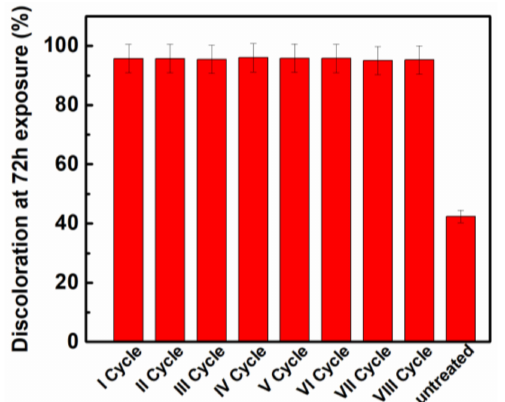
Figure 11. The repeated experiments performed for the sample PL-D under the solar light simulator. The recycling performance was investigated in forty-eight consecutive photocatalytic experiments. For each cycle, the same stone was stained with MR, exposed to the solar light simulator (1.48 mW/cm 2 ) for 72 h and, finally, the respective reflectance spectrum was recorded before the subsequent staining and irradiation cycle. The discolouration of an untreated PL sample after 1 cycle of irradiation with the solar light simulator (72 h) was reported as a